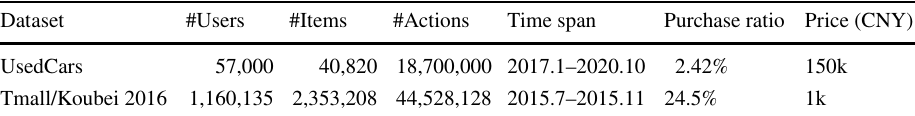
Table 2 Dataset